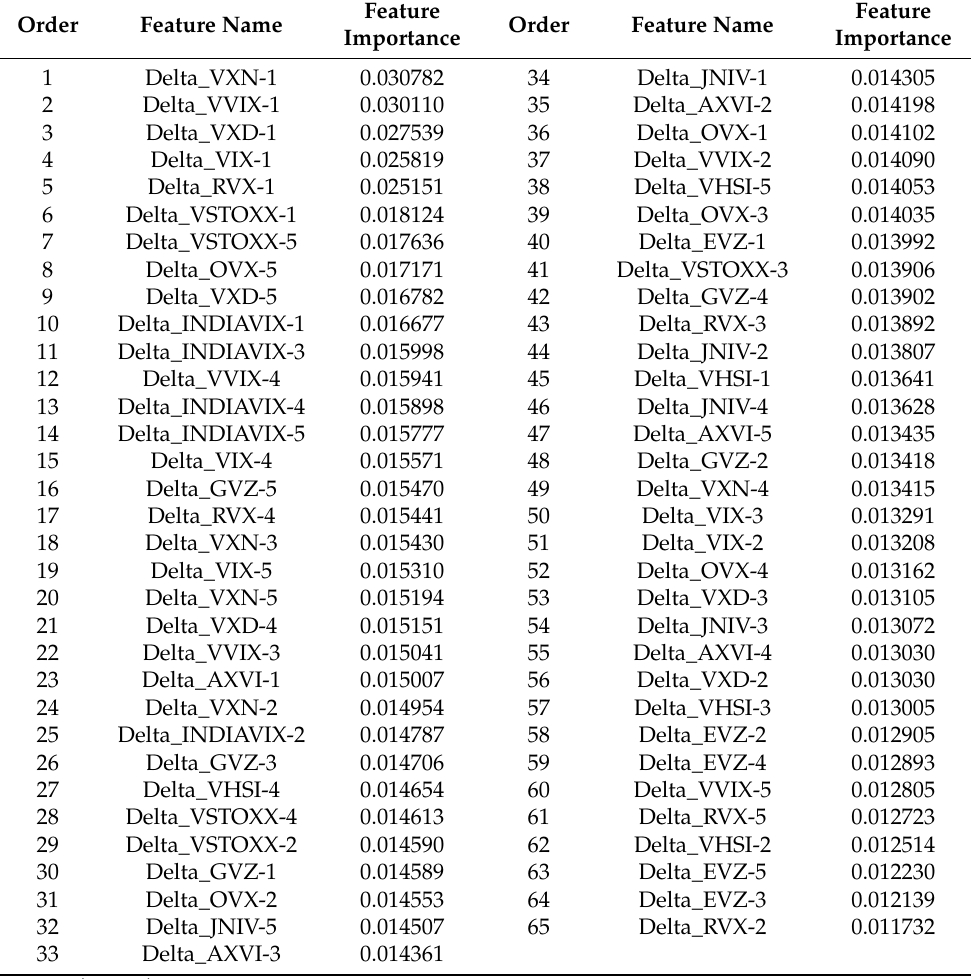
Table 10. Complete list of feature importance generated from XGBoost.